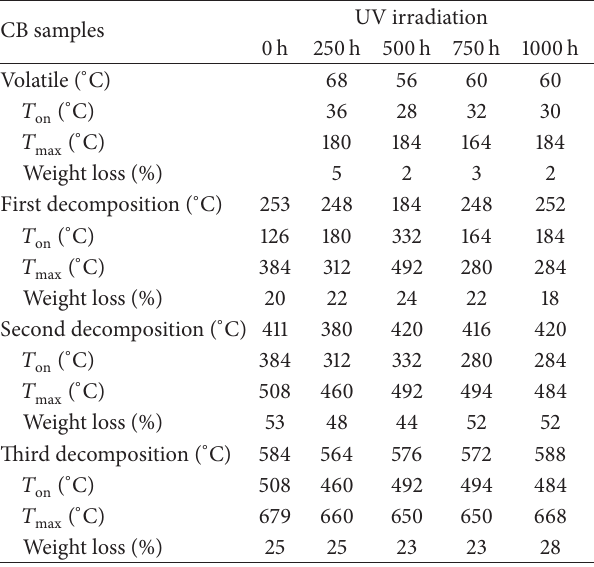
Table 2: Thermal property of CB samples with UV irradiation exposure.